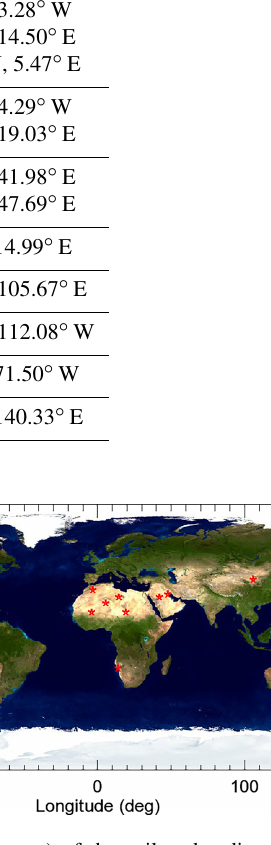
Figure 2. Locations (red stars) of the soil and sediment samples used to generate dust